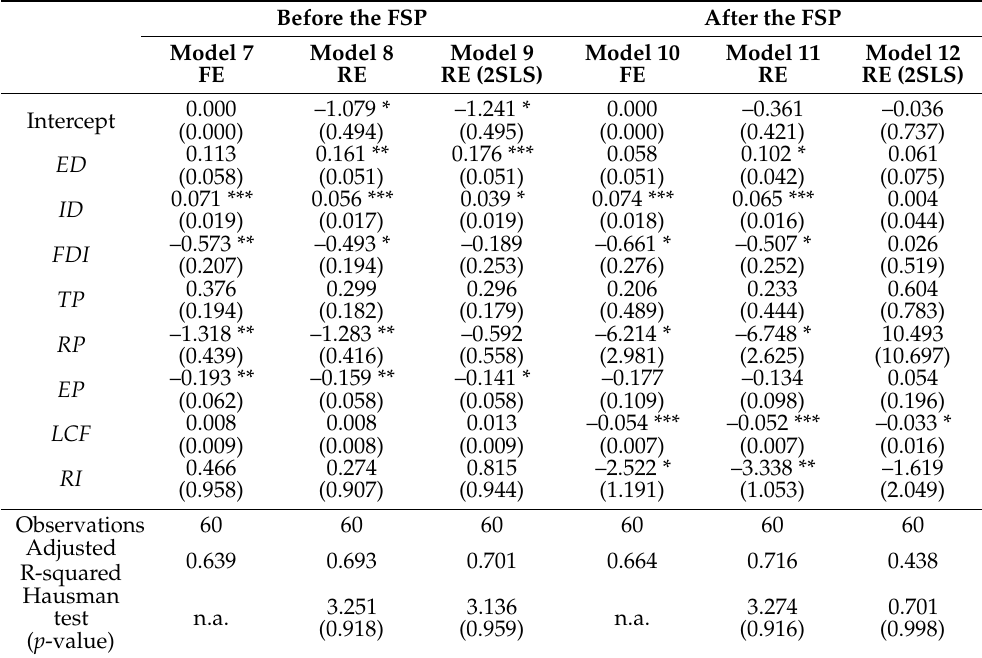
Table 3. Panel data regression results (fixed-effects (FE) and random-effects (RE)) and two-stage least squares (RE (2SLS)) estimation for Eastern